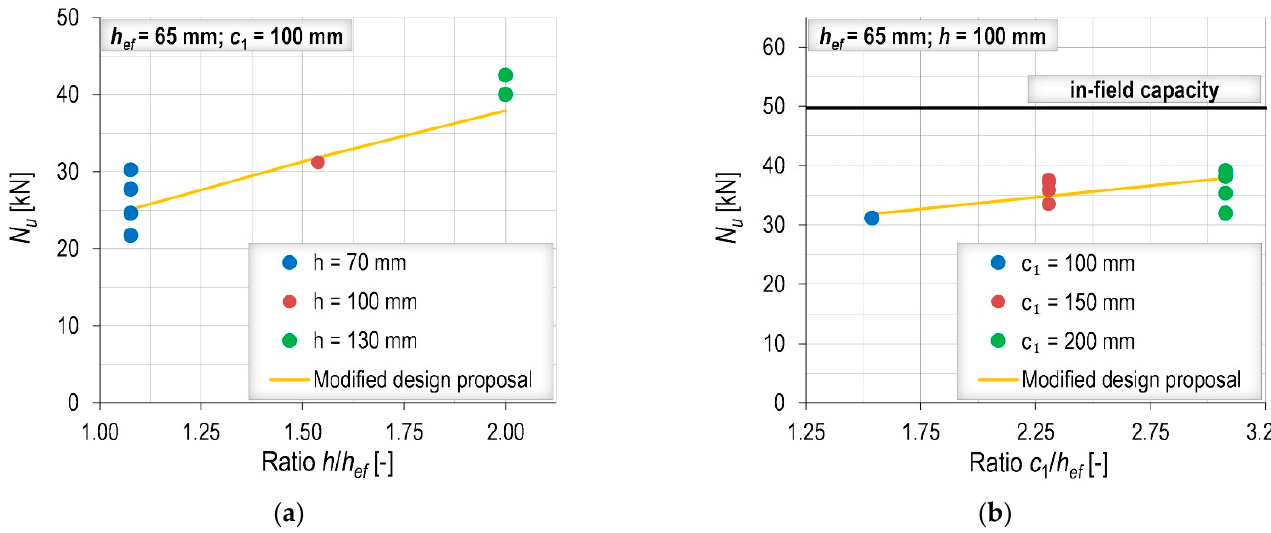
Figure 10. Experimental results: ( a ) influence of member thickness; ( b ) influence of edge distance. Table 9. Experimental results—installation near the edge.